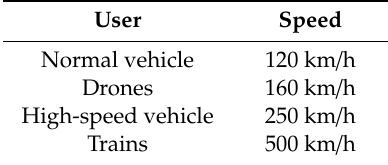
Table 4. Mobility requirements for URLLC [22].